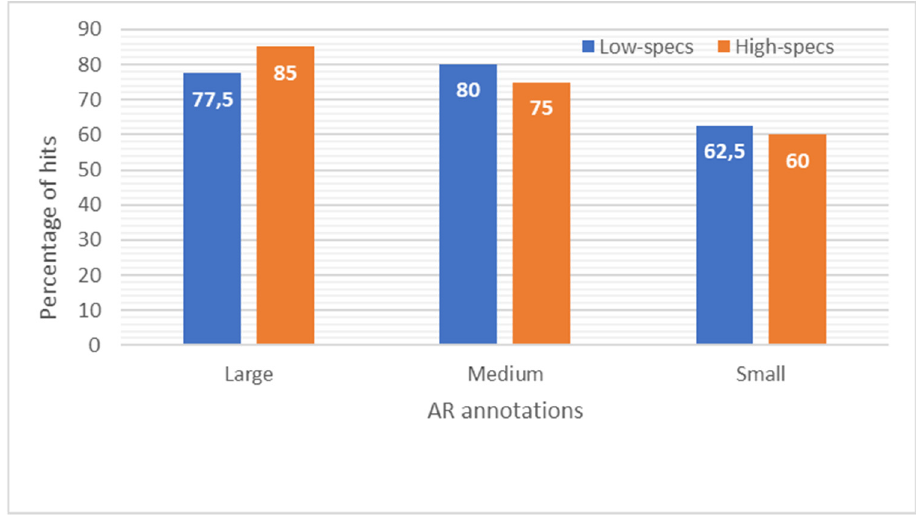
Figure 8. Percentage of hits for each of the AR annotations: large (L1 and H3), medium (L2 and H2) and small (L3 and H1).